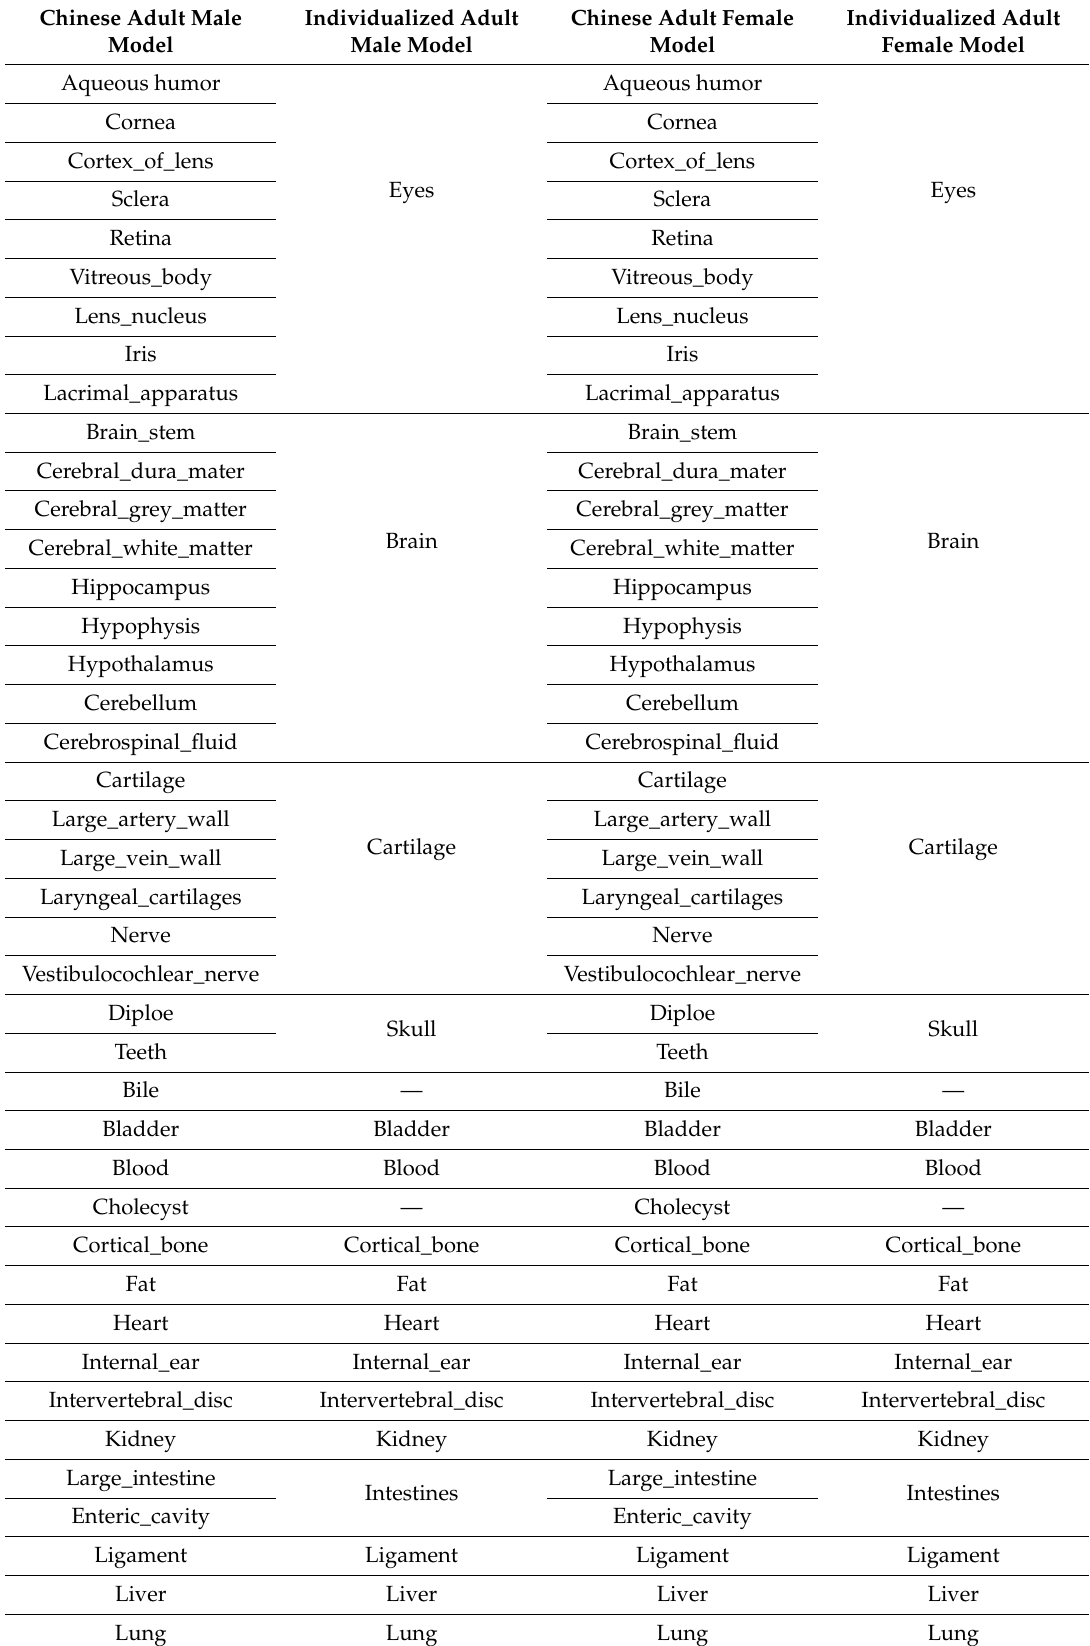
Table 1. Tissues for the different